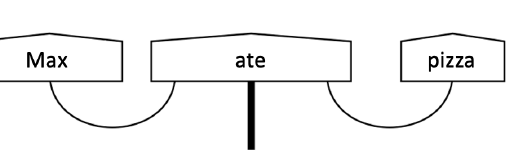
Figure 1. Example of a simple sentence represented using a string diagram inspired by formalism proposed in